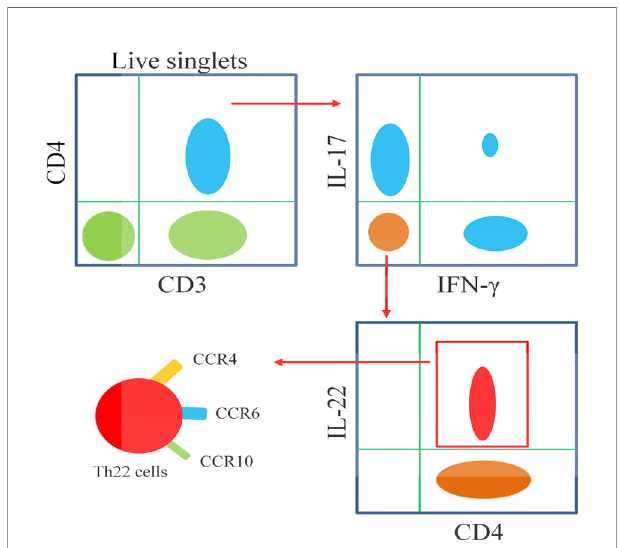
FIGURE 3 | Schematic diagram illustrates the fl ow cytometric analysis of Th22 cells. Th22 cells are identi fi ed as CD3 + CD4 + IL-17 - IFN- g - IL-22 + , as well as high expressions of CCR4,CCR6 and CCR10.